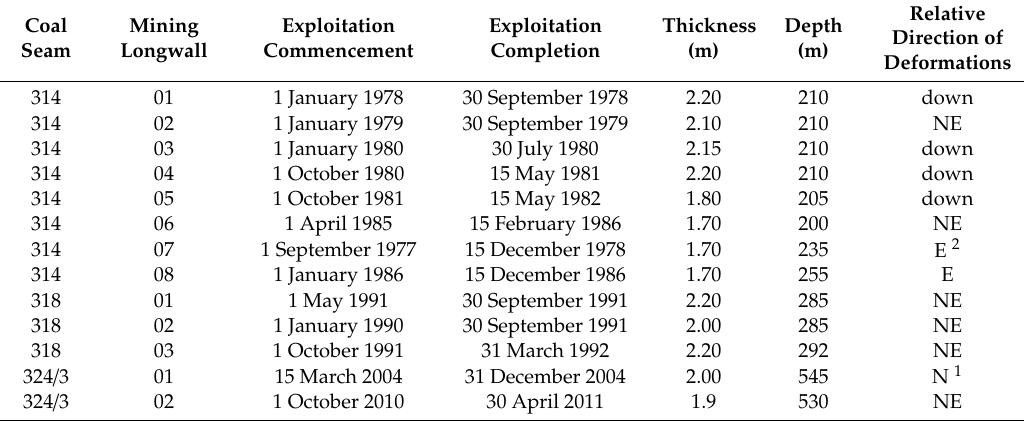
Table 1. Basic mining exploitation data concerning the area of the deformation. Coal